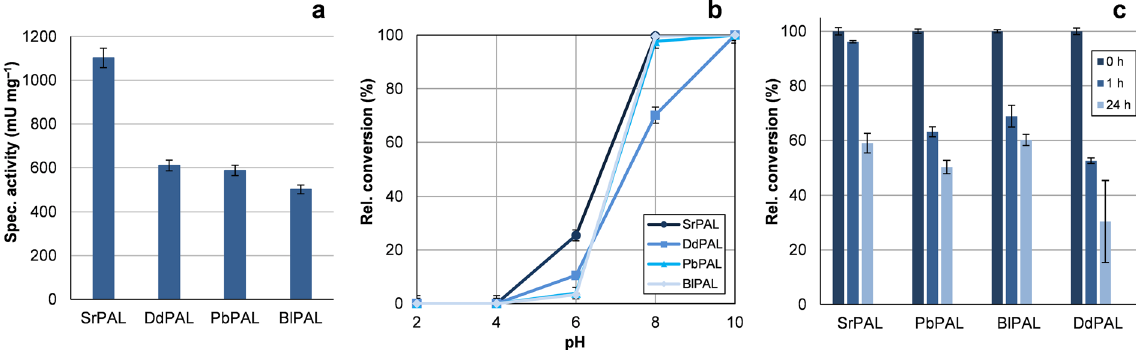
Figure 4. Variation of specific activity ( a ), pH tolerance ( b ) and stability at 37 °C ( c ) among four new ammonia lyases from Streptomyces rimosus , Brevibacillus laterosporus , Planctomyces brasiliensis and Dictyostelium discoideum which could be isolated for